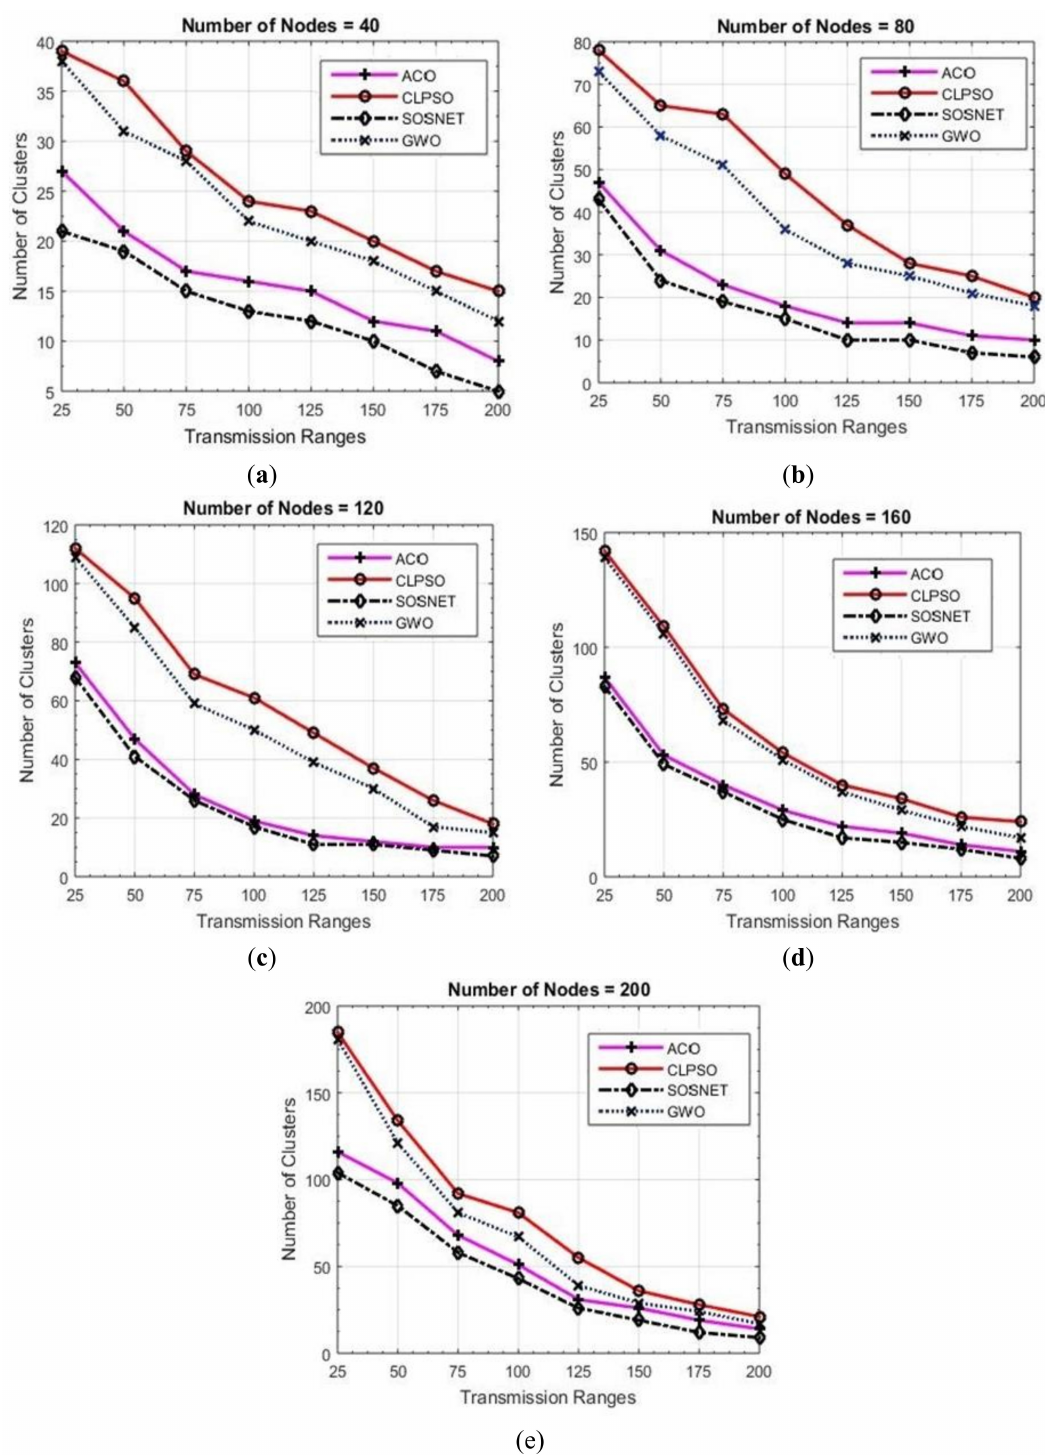
Figure 7. Grid size 1500 m × 1500 m, nodes 40 to